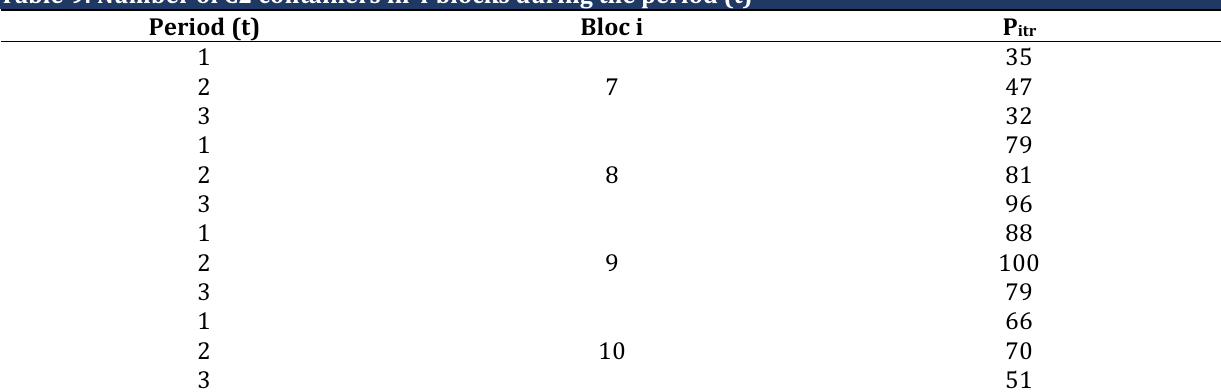
Table 9: Number of C2 containers in 4 blocks during the period (t) Period (t) Bloc